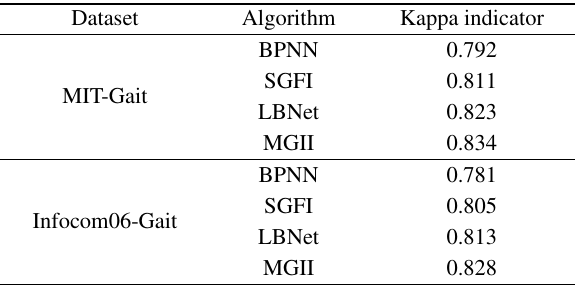
Table 1 Kappa indicator comparison.